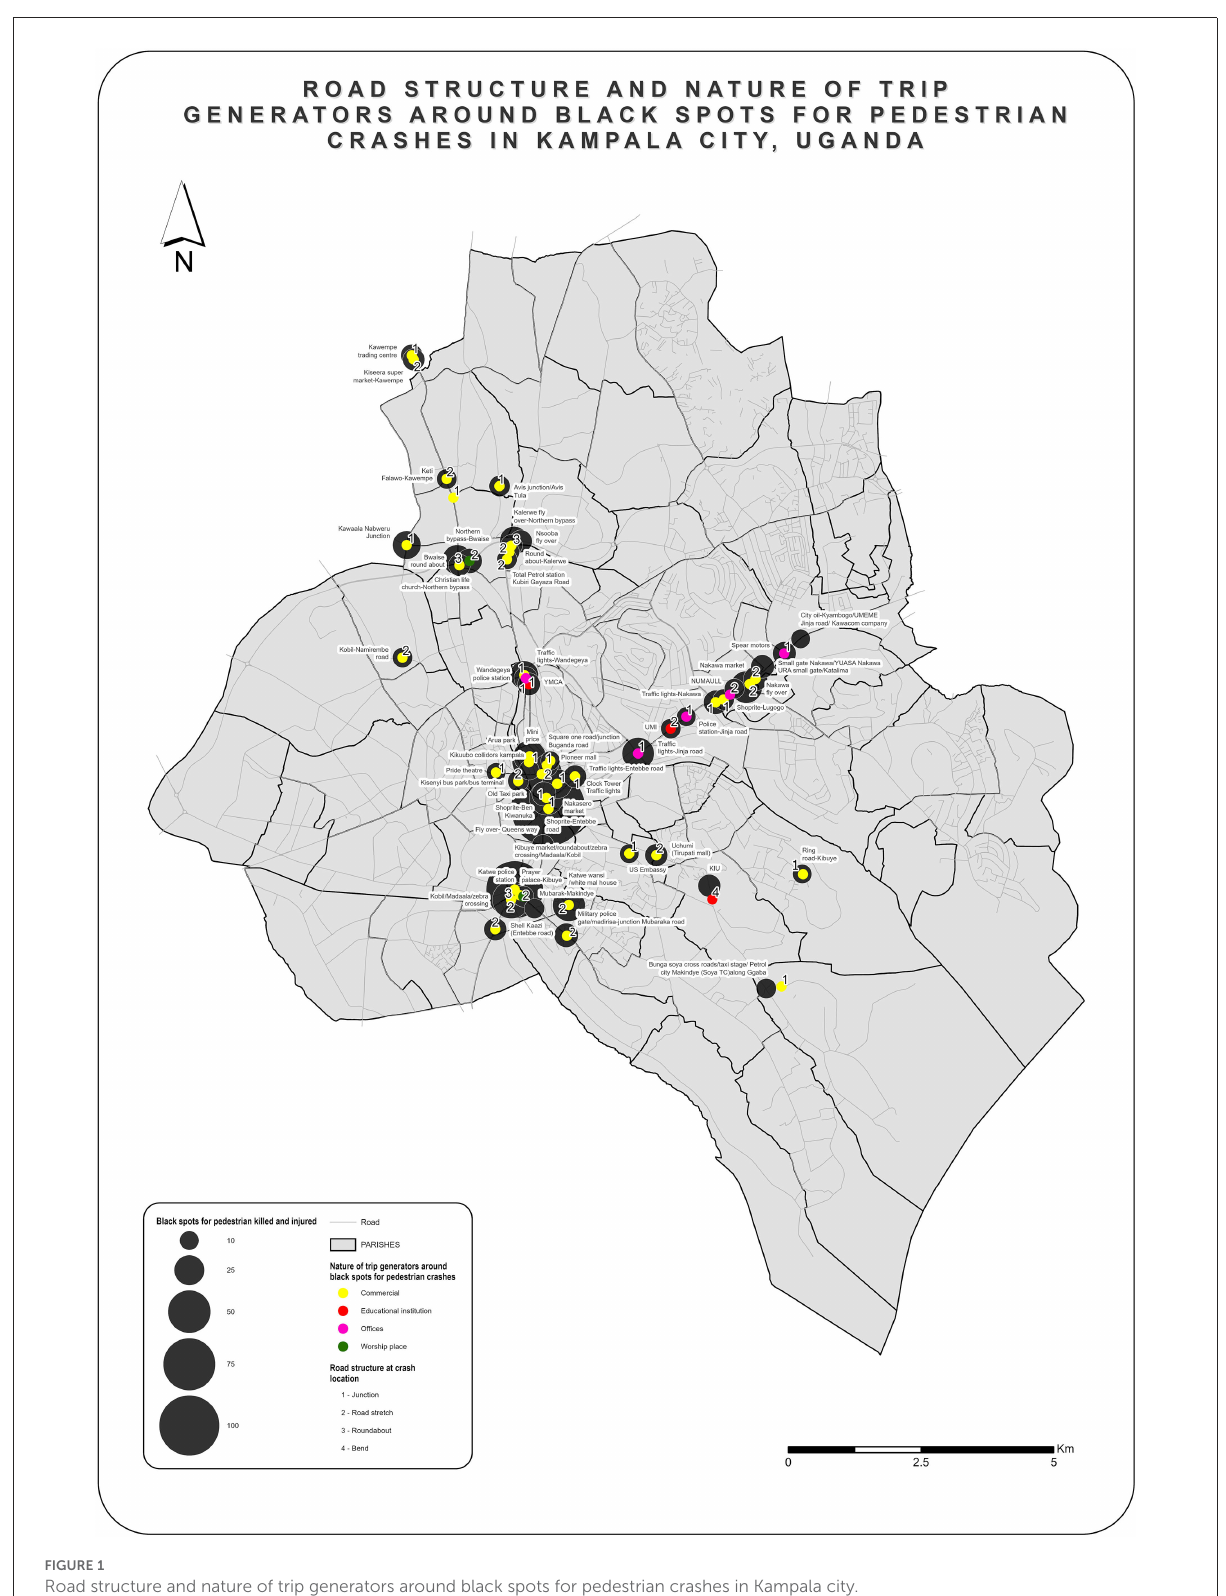
FIGURE1 Road structure and nature of trip generators around black spots for pedestrian crashes in Kampala